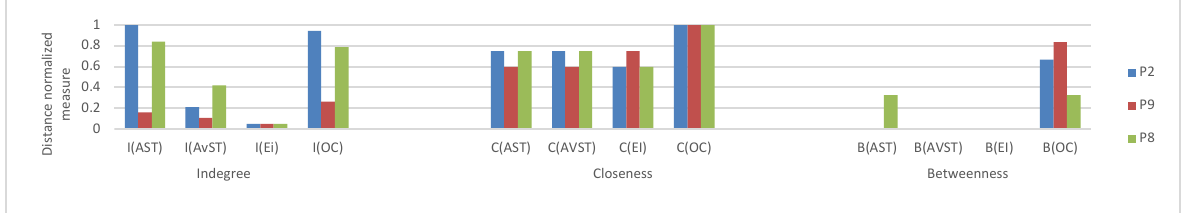
Figure 24b) Distance normalized measure values for AOIs during Climb flight phase.